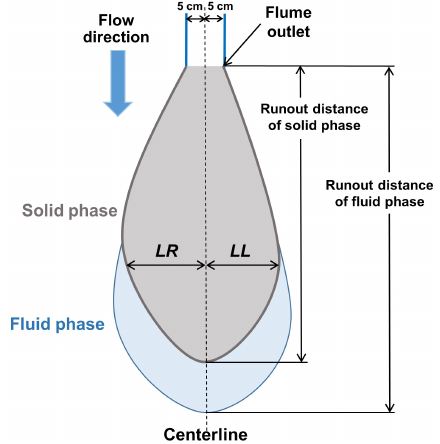
Figure 2. Sketch showing definitions of measurements associated with the flume experiments. The centerline is drawn as an extension of the central longitudinal axis of the